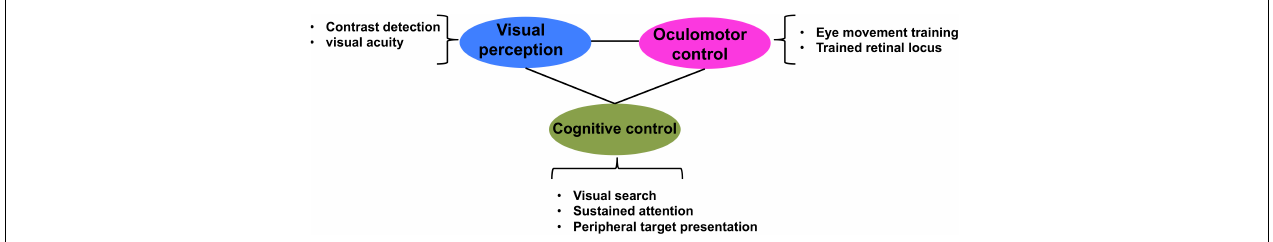
FIGURE 2 | Multidimensional approach to low vision rehabilitation in MD. Figure illustrates how each of visual perception, oculomotor control and cognitive control are interconnected dimensions of vision that contribute to effective vision.